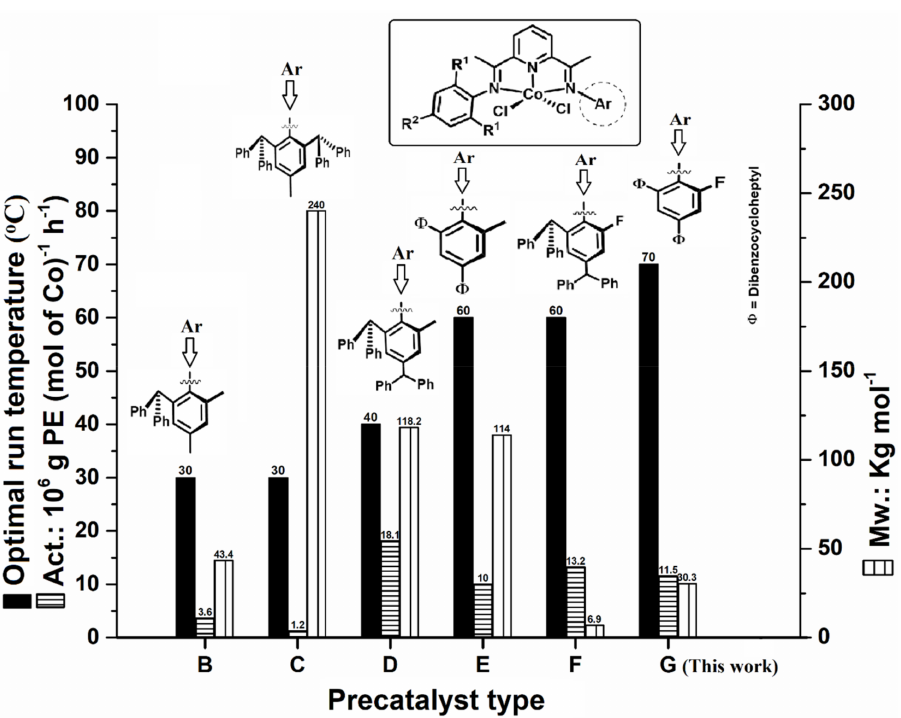
Figure 13. Comparison of catalytic activity, optimal run temperature, and polymer molecular weight data for G (this work) with that obtained using B – F . All runs were performed under optimized conditions at 10 atm of C 2 H 4 using MAO as the